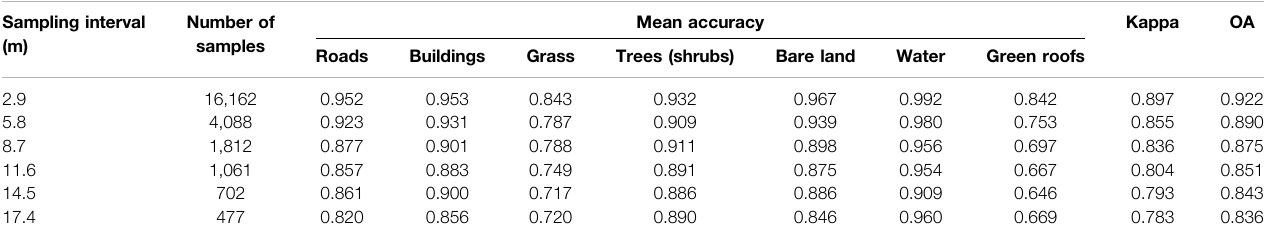
TABLE 2 | Accuracy assessment of classi fi cation at different sampling intervals. Sampling interval